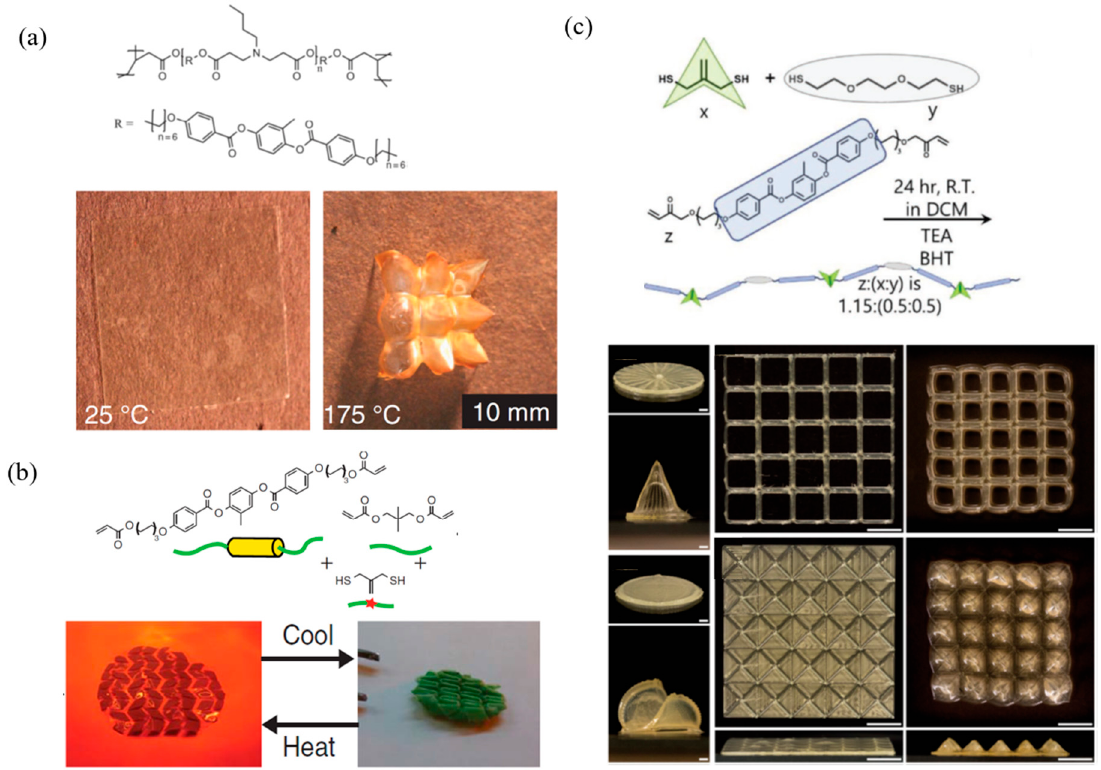
Figure 4. Predictable and complex reversible variations of LCPs. ( a ) LCP films prepared with a 3 × 3 array of +1 radial defects can be actuated to generate periodic topographical surfaces. Reproduced